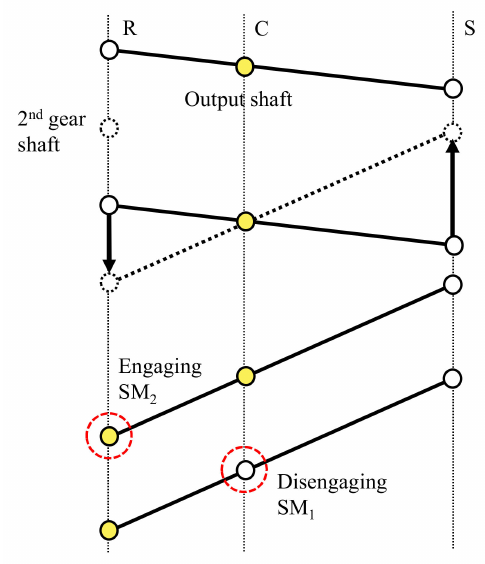
Figure 5. Lever analogy for describing shifting from odd gear-stage to even gear-stage (R: Ring gear, Engine, C: Carrier gear, S: Sun gear, Electric Motor).